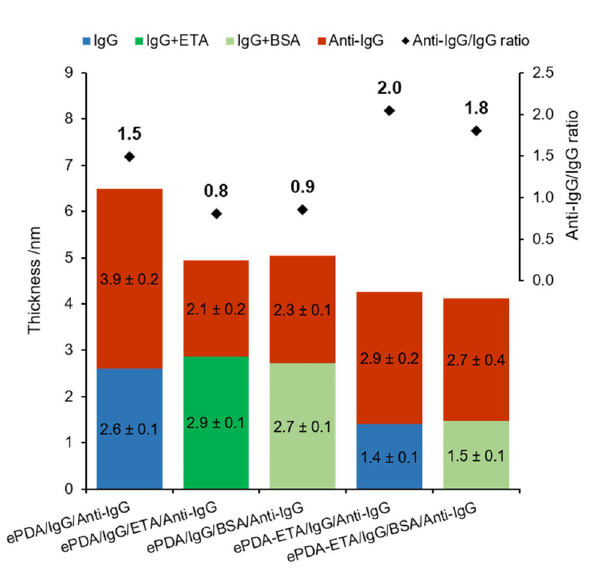
Figure 8. Representative real-time SPR curves showing the IgG and Anti-IgG interaction on gold surfaces modified with ePDA, in the absence and presence of a blocking step using either ETA or BSA; and with ePDA- ETA film, in the absence and presence of a blocking step using BSA ( a ); Anti-IgG/IgG ratios obtained from three independent SPR assays ( b ).